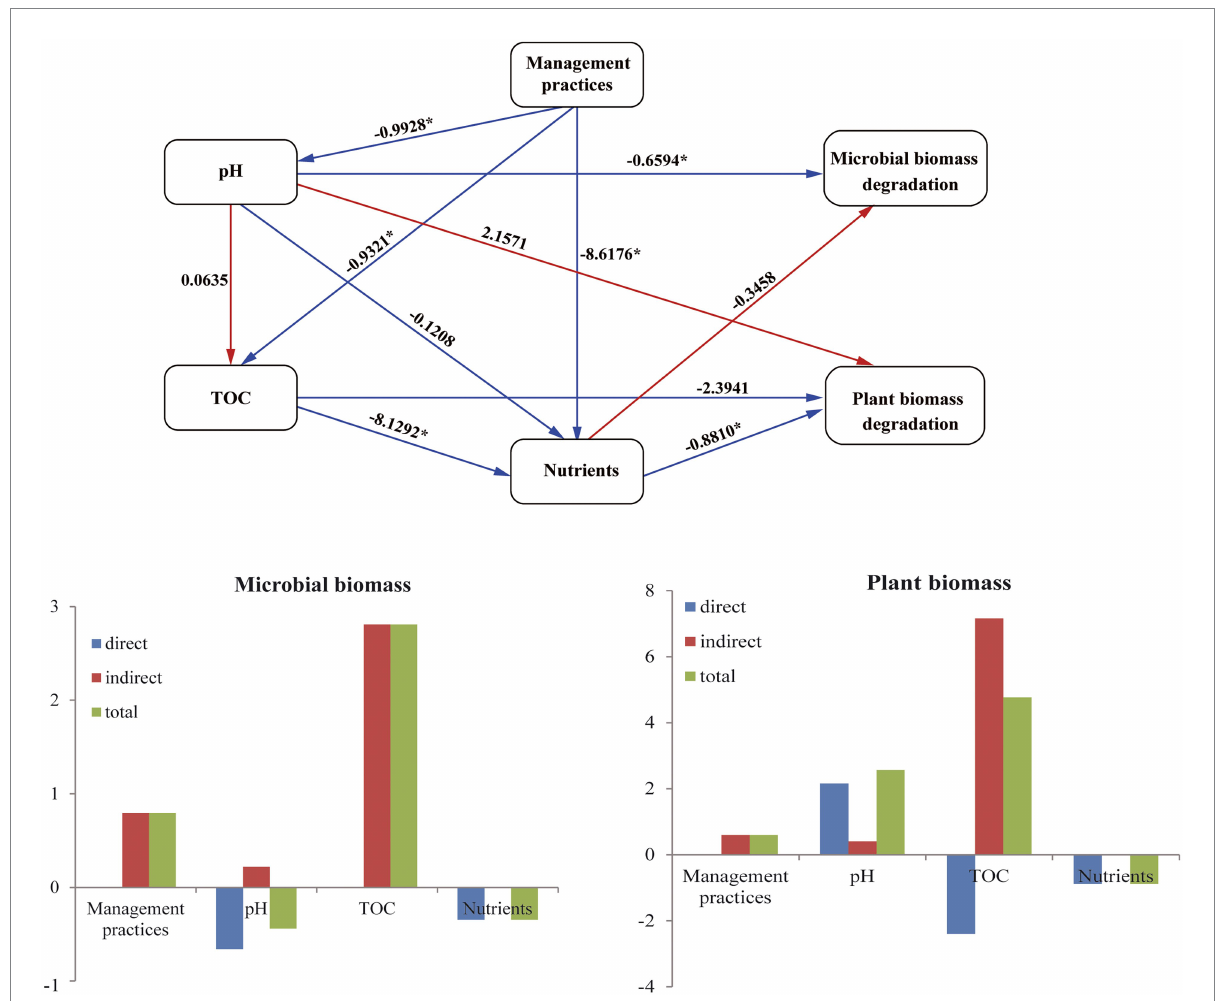
FIGURE 5 PLS-PM shows the effects of management practices on the microbial CAZyme genes for the plant- and microbial-derived biomass